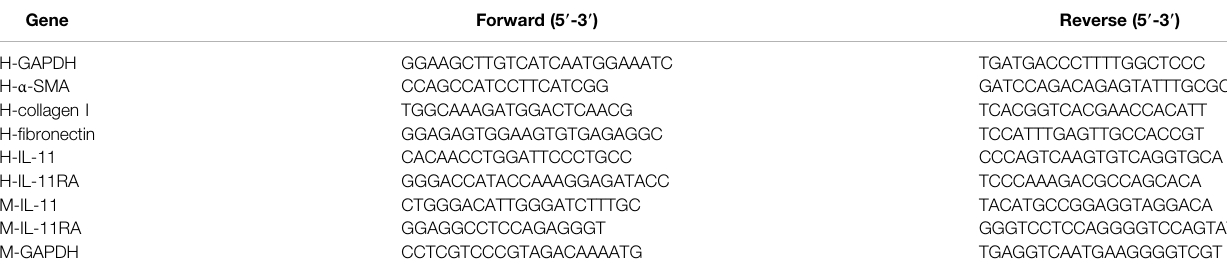
TABLE 1 | Primers used for